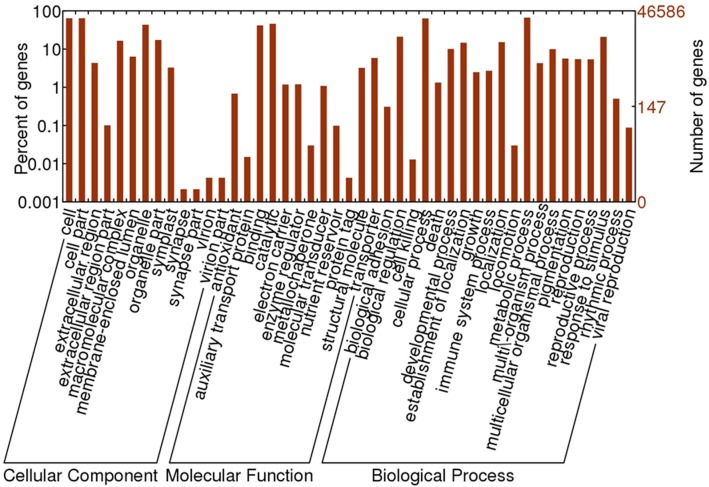
The GO annotation of R. sativus transcriptome.